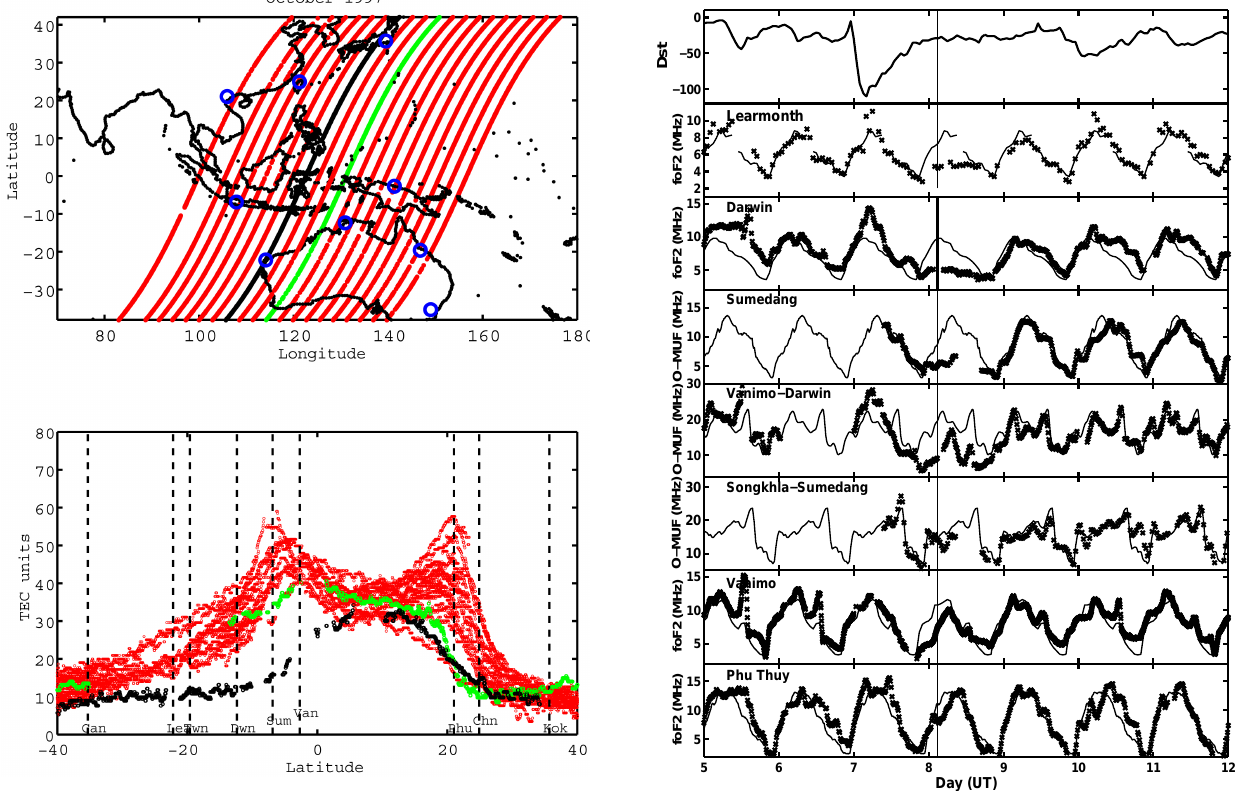
Fig. 7. D st , observed fo F2 and maximum oblique-path o-ray fre- quency values (crosses) and associated medians (line) for the pe- riod 5–12 November 1997. The time of the TOPEX/Poseidon pass on the negative ionospheric storm day of 8 November is also shown (vertical